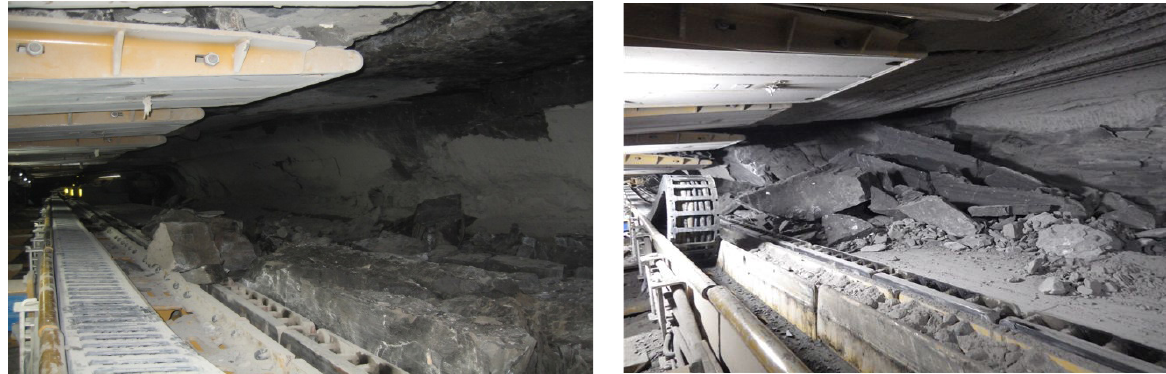
Figure 1: Failures in the 5A/1 longwall a) roof falls, b) wall